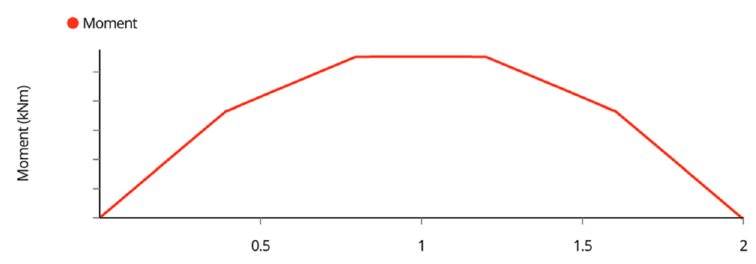
Figure A3. Joist bending moment diagram.